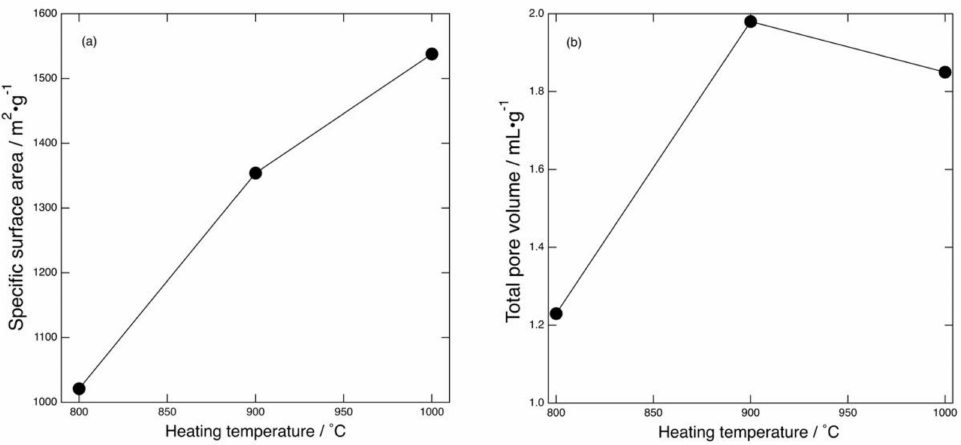
Figure 6. Specific surface area ( a ) and total pore volume ( b ) as a function of heating